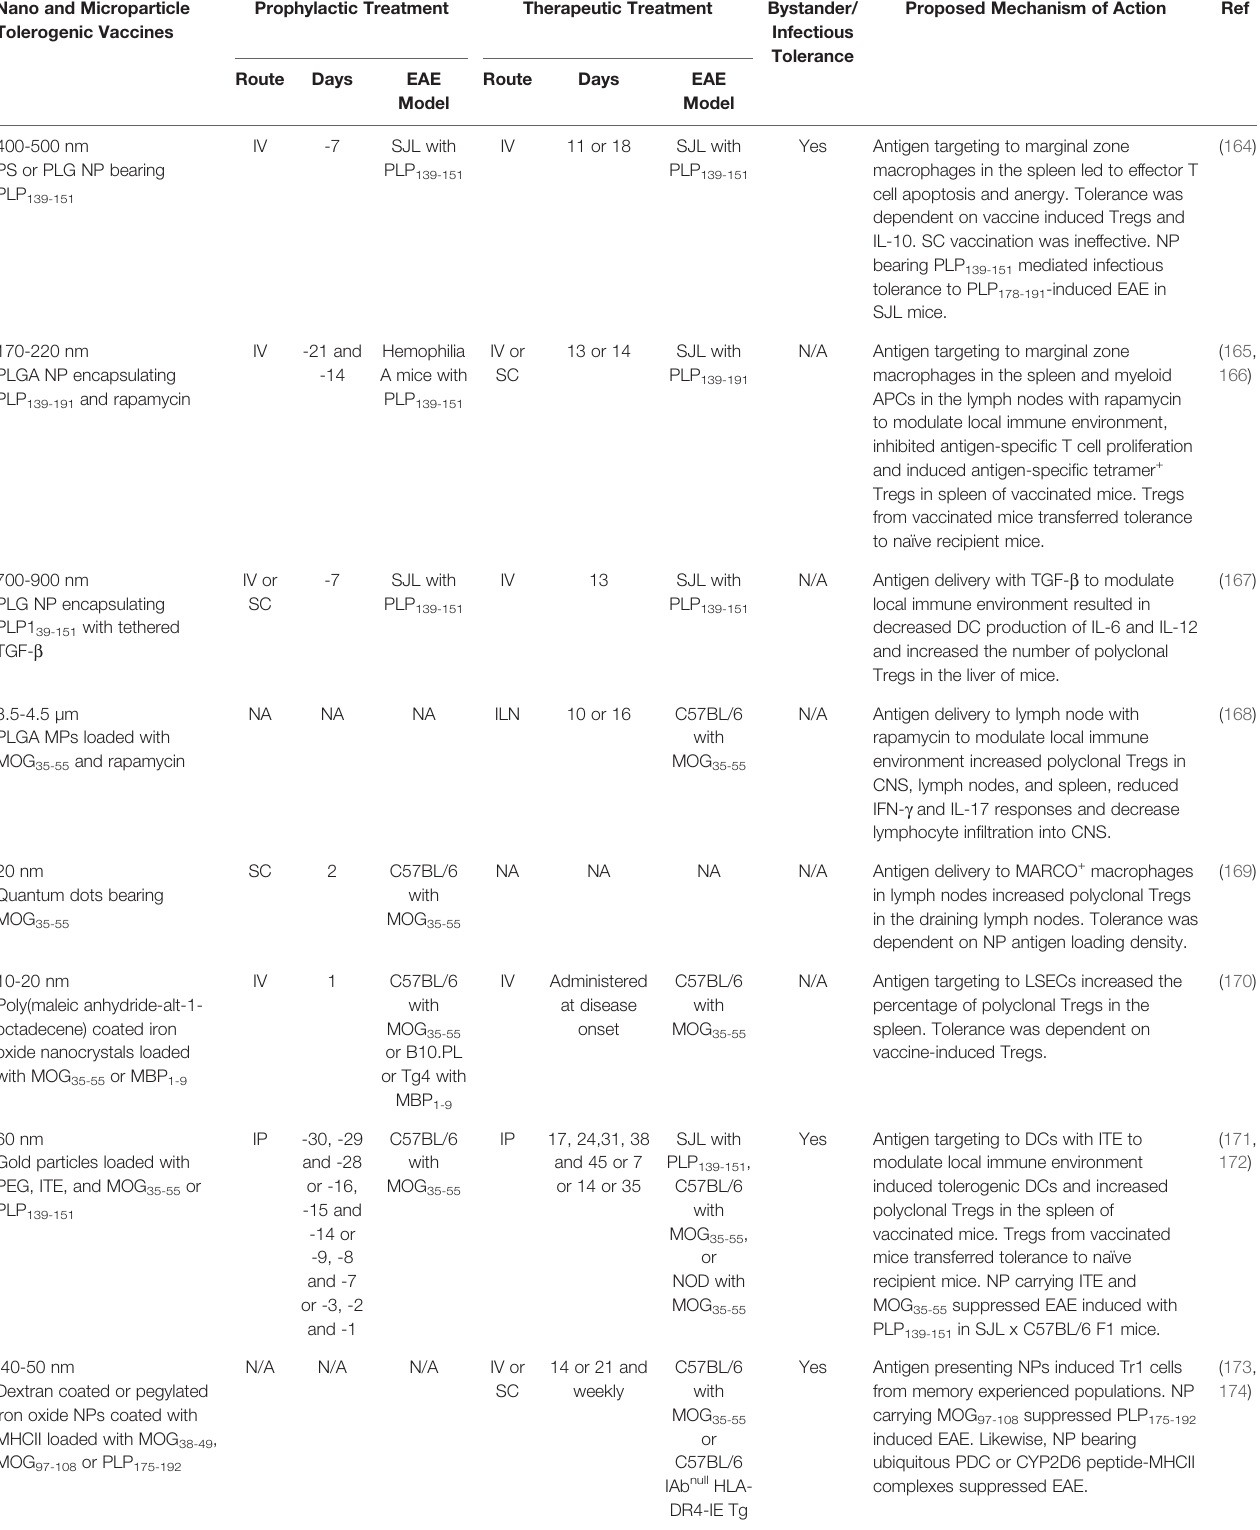
TABLE 3 | Particle-based tolerogenic